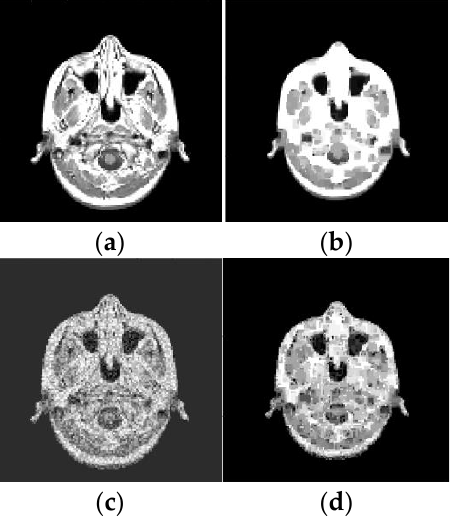
Figure 9. Results of reconstruction of MRI image based on qualitative data. ( a ) Original image; ( b ) Reconstructed image; ( c ) Original noisy image; ( d ) Reconstructed noisy image.